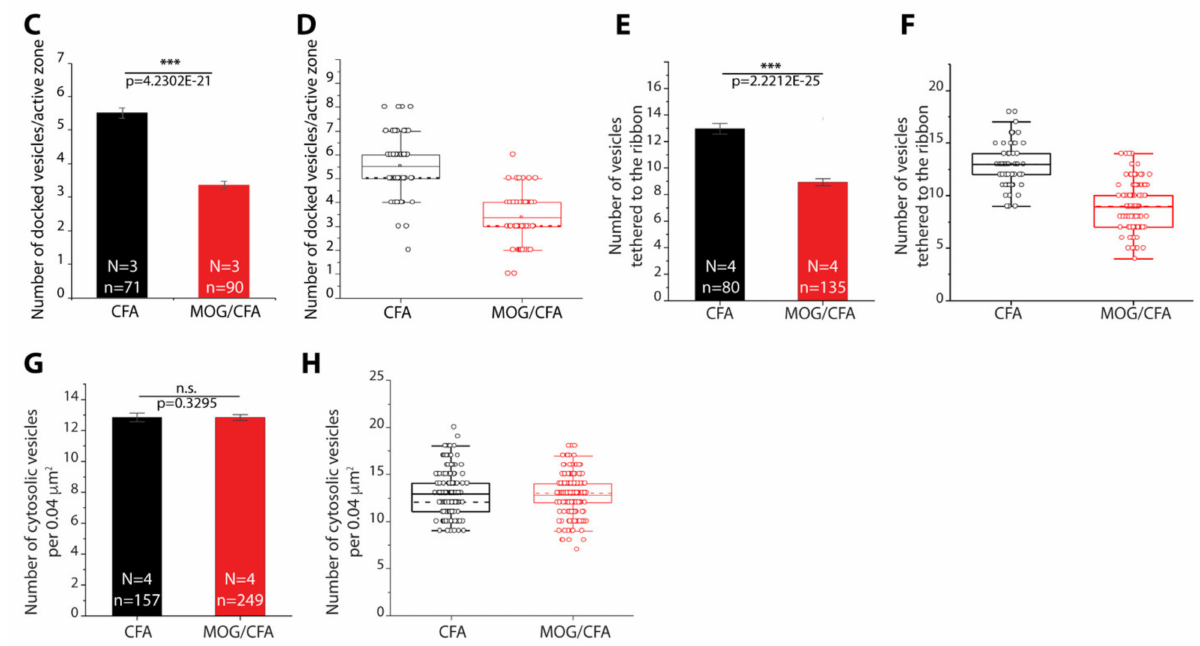
Figure 6. The number of docked vesicles and ribbon-tethered vesicles are reduced in early EAE mice in comparison to control mice. ( A1 – B2 ) Representative TEM images of rod photoreceptor synapses from CFA-injected control mice ( A1 , A2 ) and MOG/CFA-injected EAE mice ( B1 , B2 ). The yellow lines in ( A2 , B2 ) denote the 150 nm range in vicinity of the active zone in which the docked vesicles (white circles) were counted. The red spheres in ( A2 , B2 ) exemplify the ribbon-tethered synaptic vesicles. White arrows in ( A1 – B2 ) point to the arciform density. ( C , D ) Average number of docked vesicles (CFA: 5.5 ± 0.14 vesicles; MOG/CFA: 3.1 ± 0.10 vesicles). ( E , F ) Average number of ribbon tethered vesicles (CFA: 12.96 ± 0.26 vesicles; MOG/CFA: 8.93 ± 0.17 vesicles). ( G , H ) Average number of cytosolic vesicles determined in a square area of 200 × 200 nm within the presynaptic terminal in distance from the synaptic ribbon (CFA: 12.85 ± 0.18 vesicles; MOG/CFA: 12.83 ± 0.12 vesicles). Values in ( C , E , G ) are means ± S.E.M. In the box-and-whiskers plots ( D , F , H ) of the data from ( C , E , G ), mean values are indicated by solid horizontal lines; median values by dotted horizontal lines. Boxes represent the 25th–75th percentiles of data points and whiskers are equal to 1.5 times of the interquartile range (IQR). Mann–Whitney U-test was used to determine the statistical significance. Abbreviations: ho, horizontal cell dendrite; bi, bipolar cell dendrite; sv, synaptic vesicles; sr, synaptic ribbon; N, number of mice; n, number of electron microscope images of rod-photoreceptor ribbon synapses analyzed to count the synaptic vesicles; ***, p ≤ 0.001; n.s., not significant. Scale bars: 200